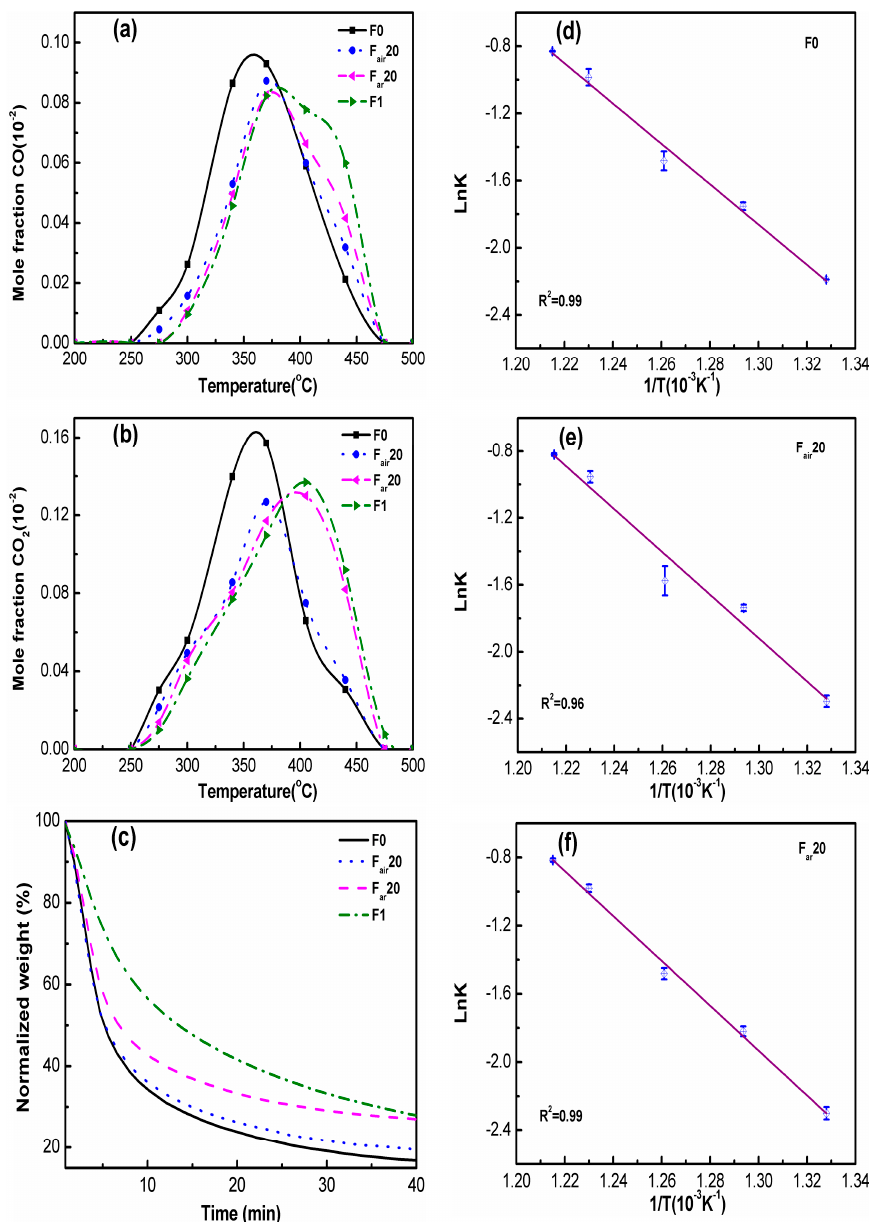
Figure 7. Oxidative behaviors and Arrhenius plot of intrinsic rate constant for samples. ( a ) CO mole fraction of four samples in TPO experiments; ( b ) CO 2 mole fraction of four samples in TPO experiments; ( c ) TGA results of isothermal oxidation for four samples at 500 ° C; ( d ) Arrhenius plot of intrinsic rate constant for F0; ( e ) Arrhenius plot of intrinsic rate constant for F air 20; ( f ) Arrhenius plot of intrinsic rate constant for F ar 20. Table 3. Apparent kinetic parameters from Arrhenius plot from isothermal oxidation in TGA under different